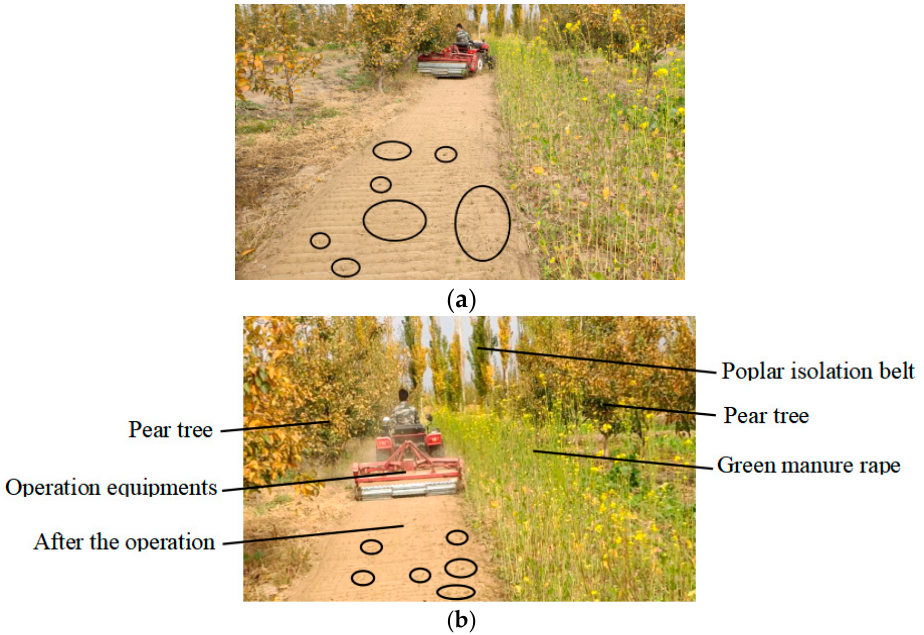
Figure 10. The elliptical position in the figure is the non-buried green fertilizer stem.